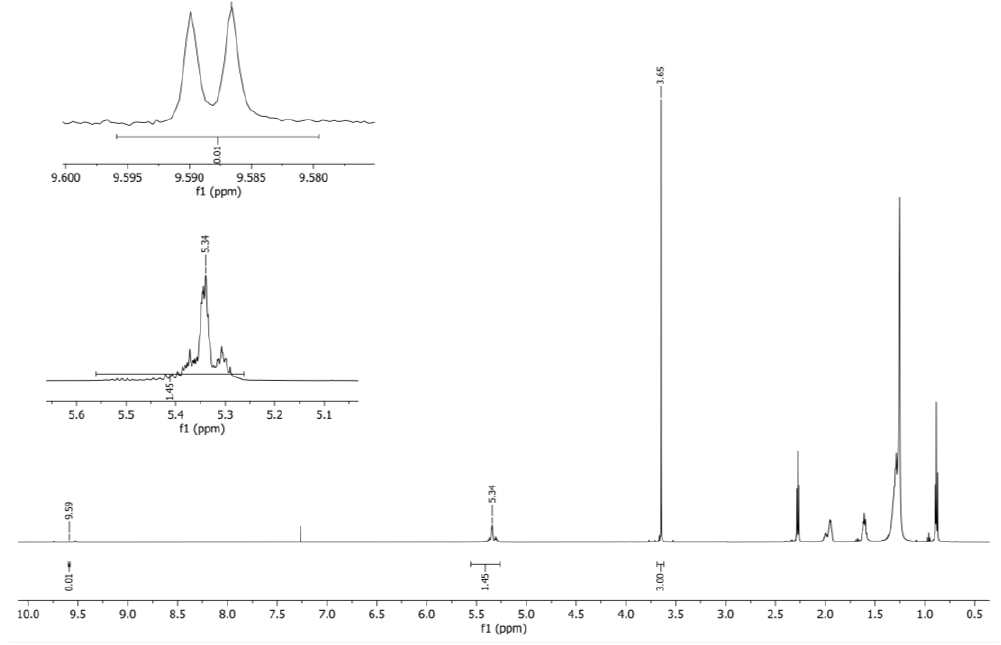
Figure 9. H NMR spectrum for hydroformylated product following the first